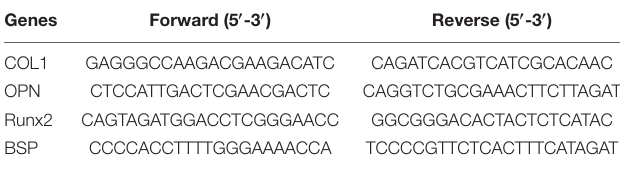
TABLE 1 | Real-time polymerase chain reaction primers used in this study.